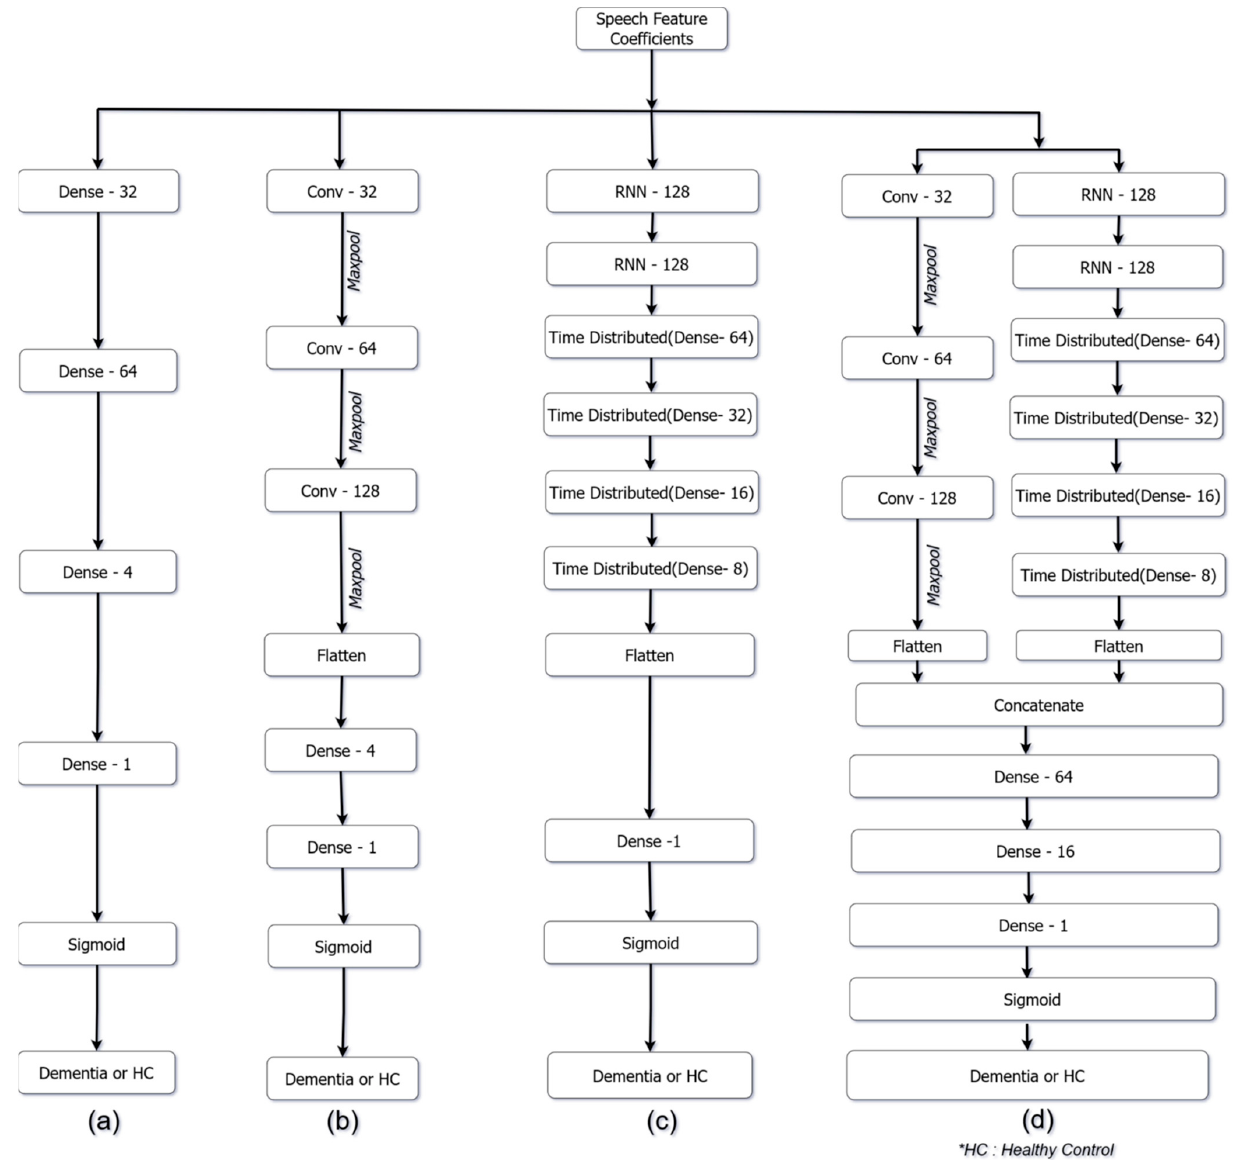
Figure 3. ( a ) ANN model design ( b ) CNN model design ( c ) RNN model design ( d ) Parallel RCNN model design.